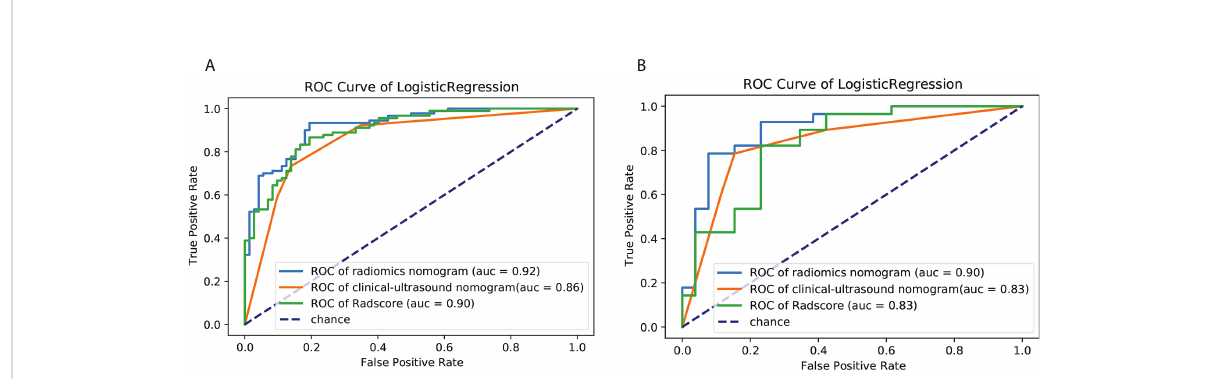
FIGURE 8 ROC curves of the clinical ultrasound nomogram,the Rad-Score and radiomics nomogram for predicting malignancy potential of GISTs in the (A) training cohort and (B) validation cohort. AUC, area under the receiver operating characteristic curve; GIST, gastrointestinal stromal